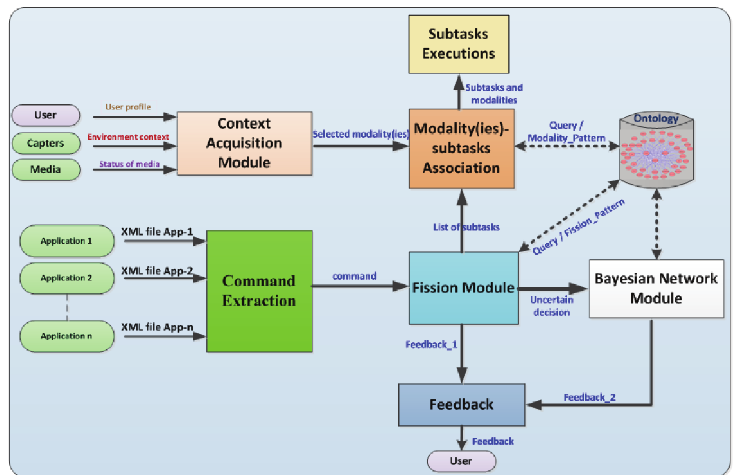
Fig.1. General approach of multimodal fission